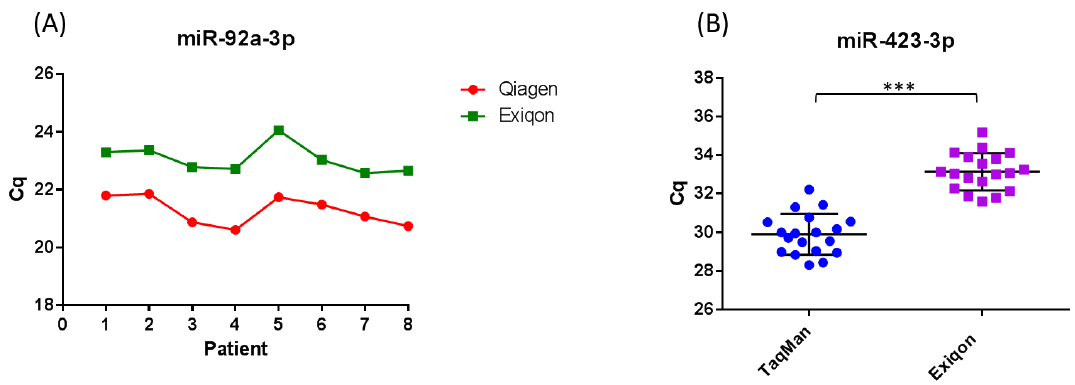
Figure 2. Evaluation of the miRNeasy (Qiagen) and miRCURY (Exiqon) extraction kits. ( A ) Eight healthy blood donors were used. RNA was extracted from 200 µ L serum using the miRNeasy RNA isolation kit (Qiagen) and miRCURY RNA isolation kit Biofuids (Exiqon) following the manufacturer’s instructions, and eluted in 14 µ L and 50 µ L of RNase free water respectively. TaqMan microRNA quantitative reverse transcription polymerase chain reaction (qRT-PCR) (Applied Biosystems, Waltham, MA, USA) was carried out against miR-423-3p, a normalizer recommended by Exiqon. Cq values for miR-423-3p obtained from RNA extracted using the miRNeasy RNA isolation kit (Red) verses Cq values obtained from RNA extracted using the miRCURY RNA isolation kit Biofluids (Green) are displayed. ( B ) Eighteen healthy blood donors were used. RNA was extracted from 200 µ L serum using the miRCURY RNA isolation kit Biofluids (Exiqon). TaqMan microRNA qRT-PCR and miRCURY™ LNA™ Universal RT microRNA polymerase chain reaction (PCR) (Exiqon) was carried out against miR-423-3p. Cq values for miR-423-3p obtained using the TaqMan chemistry are displayed in blue and the Cq values for miR-423-3p obtained using the SYBR-Green based (Exiqon) chemistry are displayed in yellow (see also Supplementary data). *** p < 0.001.